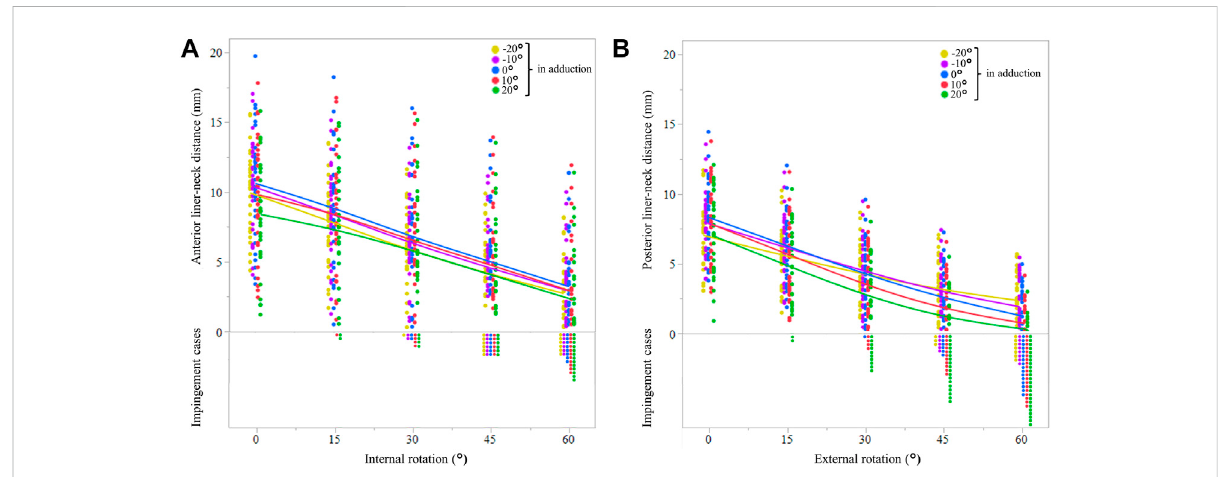
FIGURE 4 Anteriorliner-to-neckdistancesarebasedonthesimulatedinternalrotationandadductionatmaximumhip fl exion (A) .Yellow,violet,blue,red, and green solid lines represent average values of − 20 ° , − 10 ° , 0 ° , 10 ° , and 20 ° in adduction, respectively. The dots show the actual values for each patient in each simulation. The posterior liner-to-neck distances are based on the simulated external rotation and adduction at maximum hip extension (B) .Yellow,violet,blue,red,andgreensolidlinesrepresentaveragevaluesof − 20 ° , − 10 ° ,0 ° ,10 ° ,and20 ° inadduction,respectively.The dots show the actual values for each patient in each